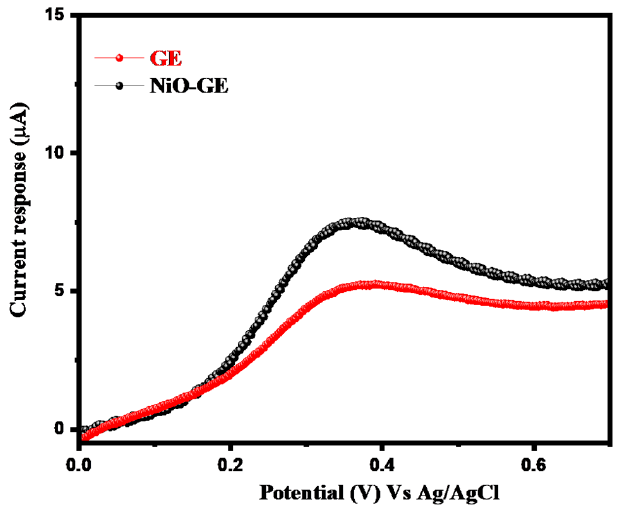
Figure 9. LSV response of GE and NiO-GE for 5 ppb As 3+ (0.1 M PBS of pH = 6) at scan rate = 50 mVs − 1